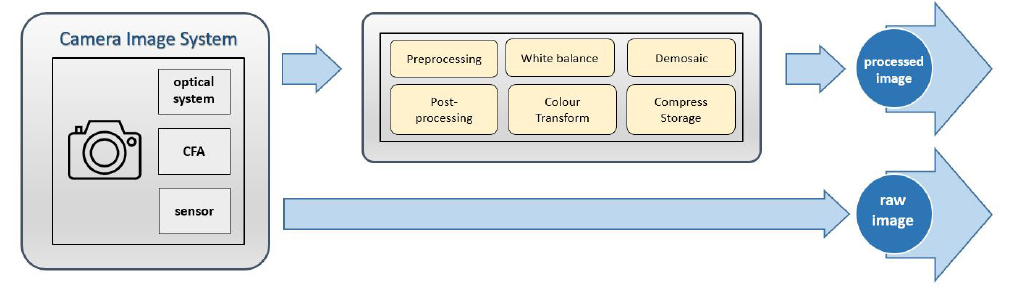
Figure 2. Raw images versus processed images